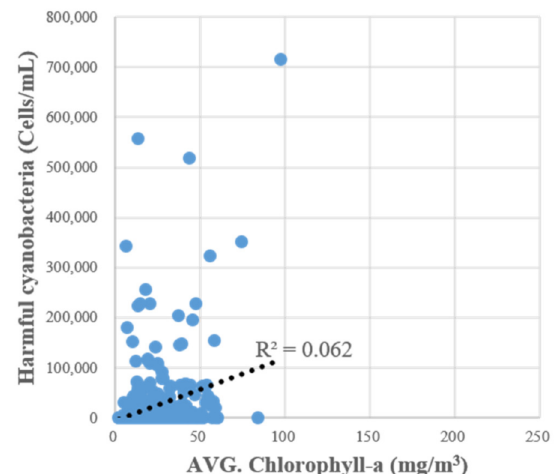
Figure A3. Correlation between average chlorophyll-a and harmful